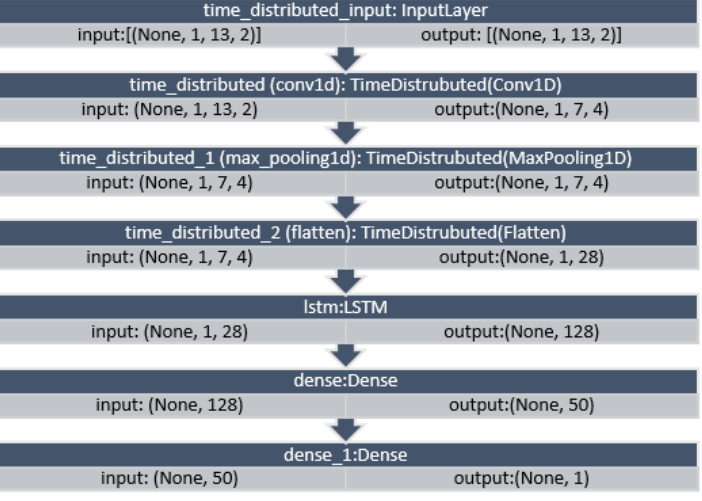
Figure 12. CNN – LSTM layers for the seventh iteration with (d0, o1) for the Manchester dataset. As for parameters, CNN had three layers: 1. — Conv1D with a dilation rate of 6 and group 2 with 4 filters and a kernel size of 2; 2. — the maximum pooling layer had a size of